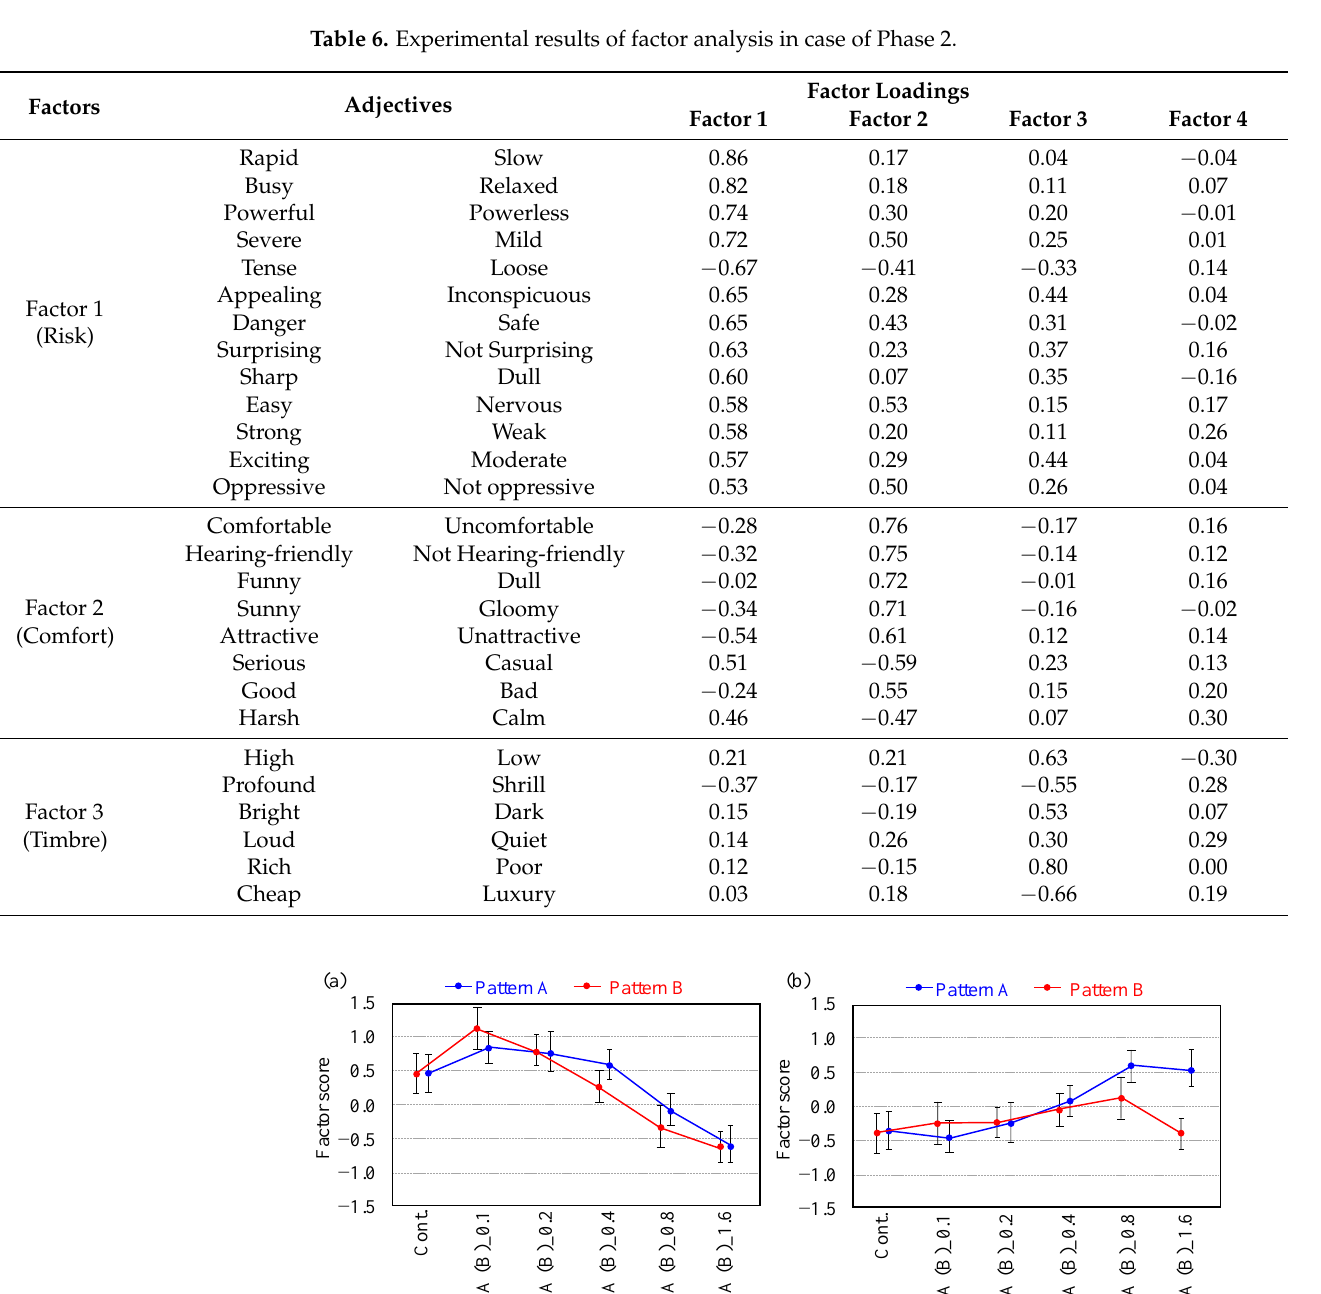
Figure 9. Average factor scores and associated SDs (error bars indicate 95% confidence interval) for ( a ) Factor 1 (risk) and ( b ) Factor 2 (comfort).